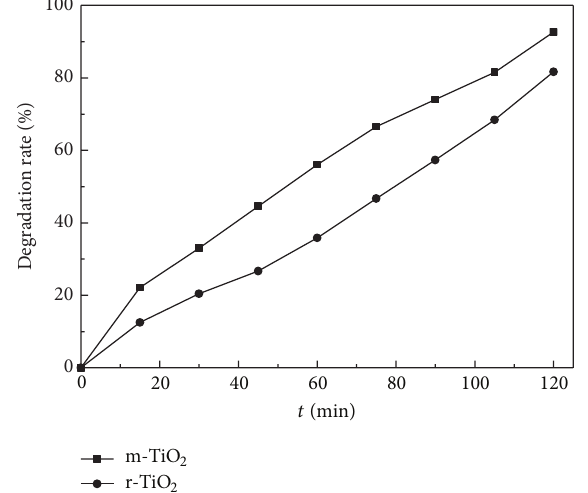
Figure 5: Degradation efficiency curves of RhB for the r-TiO 2 and m-TiO 2 after calcination at 500 ∘ C for 2